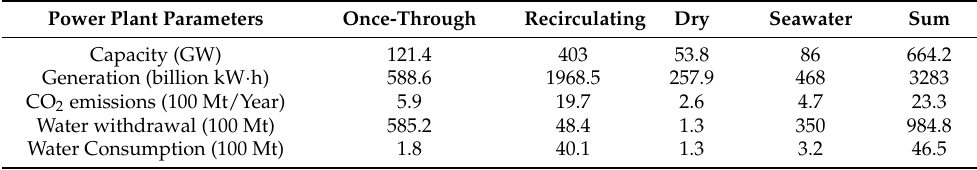
Table 3. Technical statistics of different cooling types on power plants without CCS